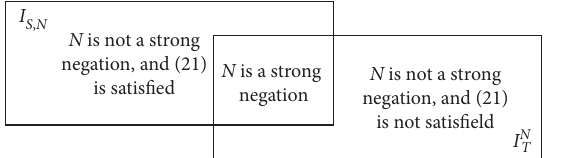
Figure 1: Intersection between ( S, N ) - and ( T,N )